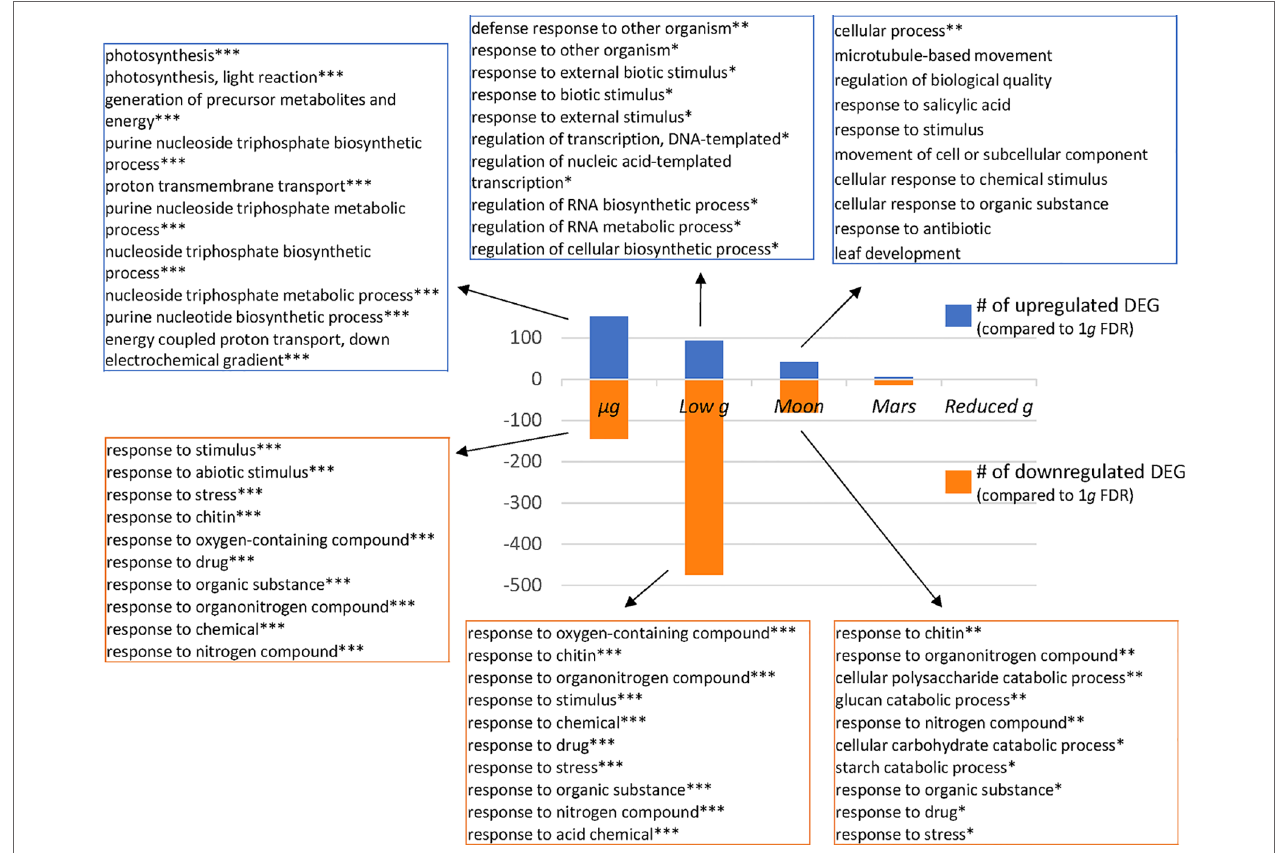
FIGURe 5 | Biological processes affected by reduced gravity (Panther Enrichment in biological process GO). Total number of up-regulated and down-regulated DEG (p < 0.05) are shown for the five reduced gravity conditions vs. 1 g control. The ten most significant gene ontology (Panther biological process GO Enrichment) categories for the three upregulated and the three downregulated DEGs are shown for the microgravity, low gravity (circa 0.1 g ) and Moon gravity (0.18 g ) vs. 1 g ( *** FDR q < 0.001, **FDR q < 0.01, *FDR q > 0.05).